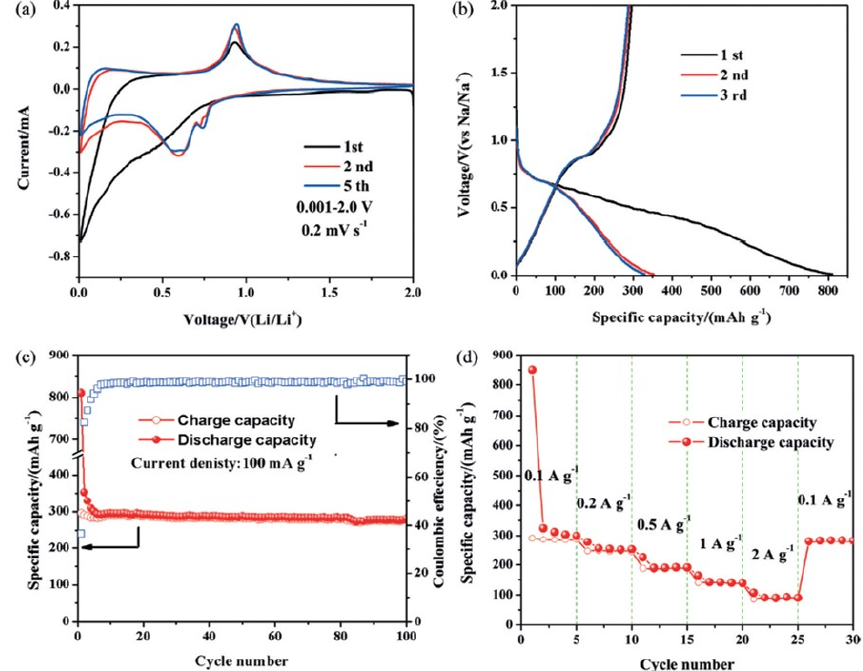
Figure 2. ( a ) Cyclic voltammograms (CV) ( b ) electrochemical charging and discharging ( c ) cyclic stability at 100 mAg − 1 rates. ( d ) cyclic stability at different current rates of Bi@C microspheres [54]. Reproduced with permission. Copyright 2016, Wiley.